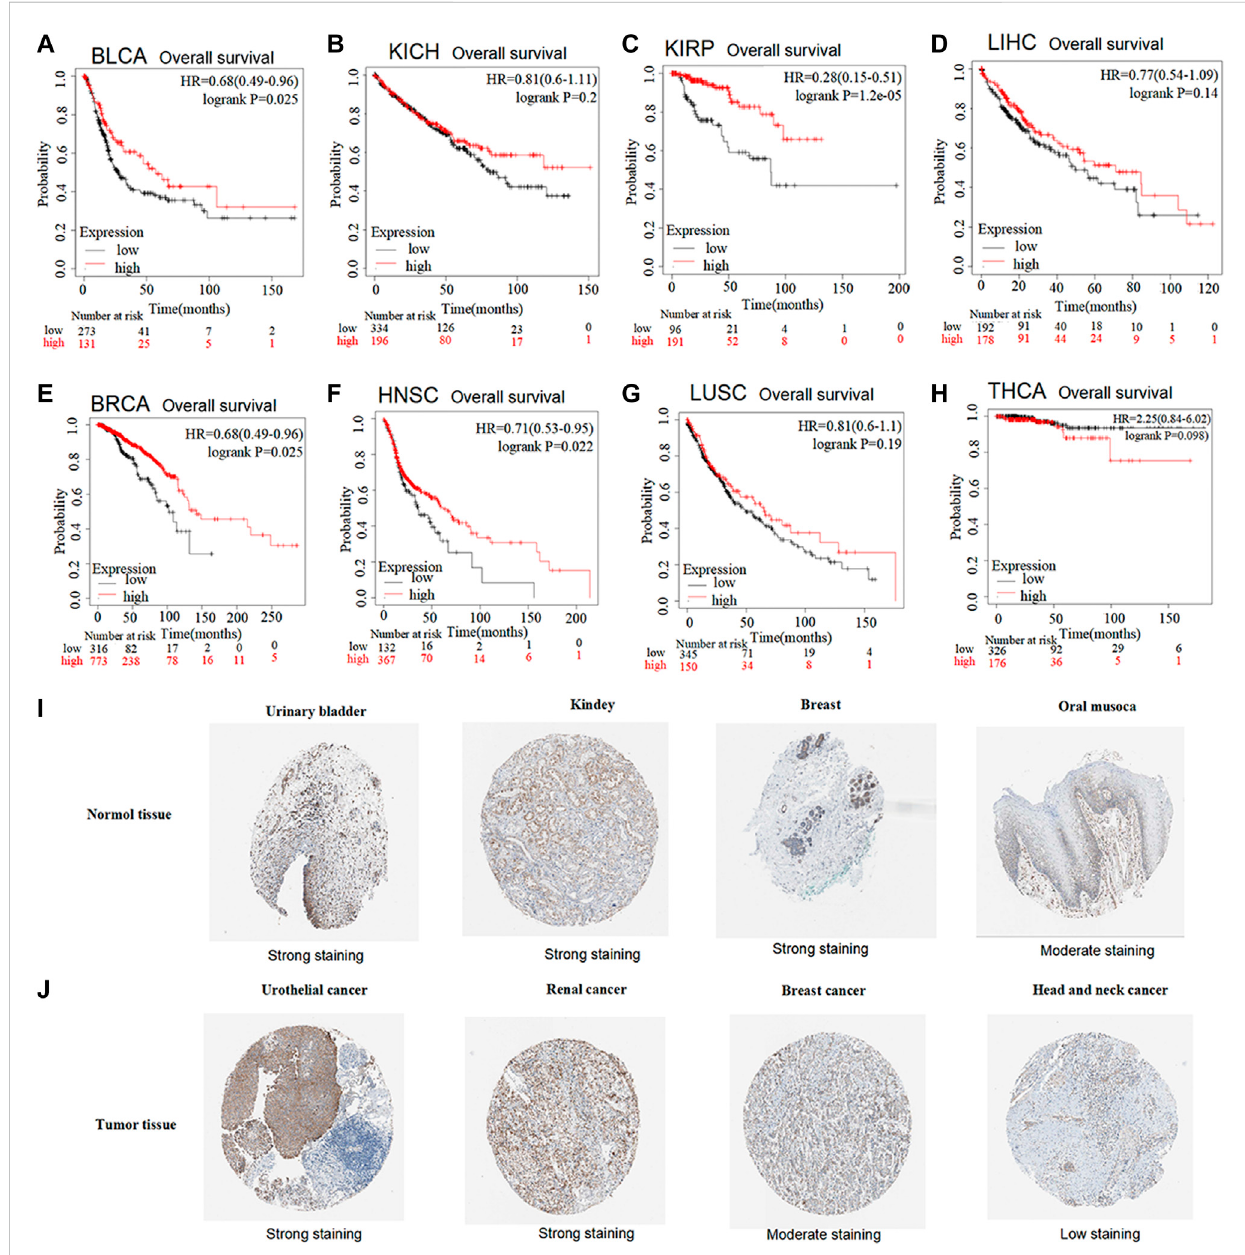
FIGURE 2 Prognostic value of low vs. high GSTK1 expression analyzed with the Kaplan-Meier plotter database and the Human Protein Atlas (HPA) database (A – H) Kaplan – Meier survival curves for BLCA (A) , KICH (B) , KIRP (C) , LIHC (D) , BRCA (E) , HNSC (F) , LUSC (G) , THCA (H) tumors with high and low GSKT1expressionanalyzedusingtheKaplan-Meierplotterdatabase (I) ValidationoftheexpressionlevelofGSTK1invariousnormaltissuesusingtheHPA database (immunohistochemistry). (J) Validation of the expression level of GSTK1 in various tumors using the HPA database (immunohistochemistry). (BLCA, bladder urothelial carcinoma; KICH, kidney chromophobe; LIHC, liver hepatocellular carcinoma; BRCA, breast invasive carcinoma; HNSC, head and neck squamous cell carcinoma; LUSC, lung squamous cell carcinoma; THCA, thyroid